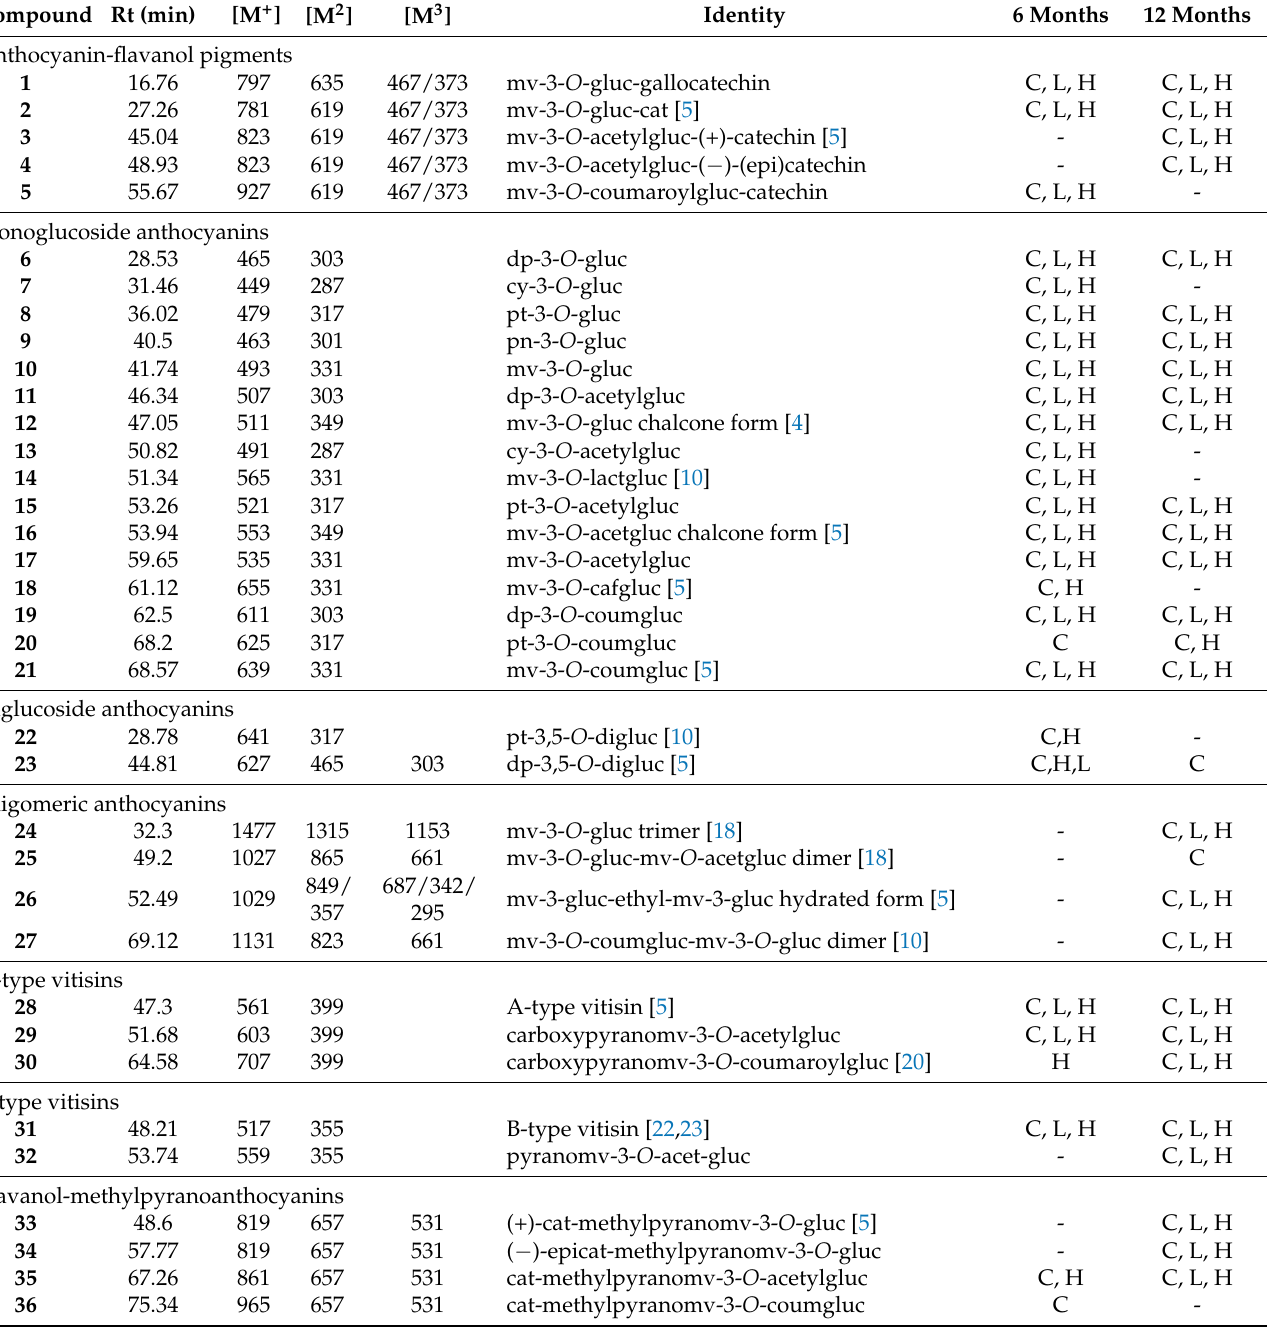
Table 3. Anthocyanins and their derivatives identified in red wines aged in barrels with different OTR by LC/DAD-MS (control (C) ( N = 2), LW-OTR (L)( N = 4) and HW-OTR (H) ( n = 4) at 6 and 12 months of